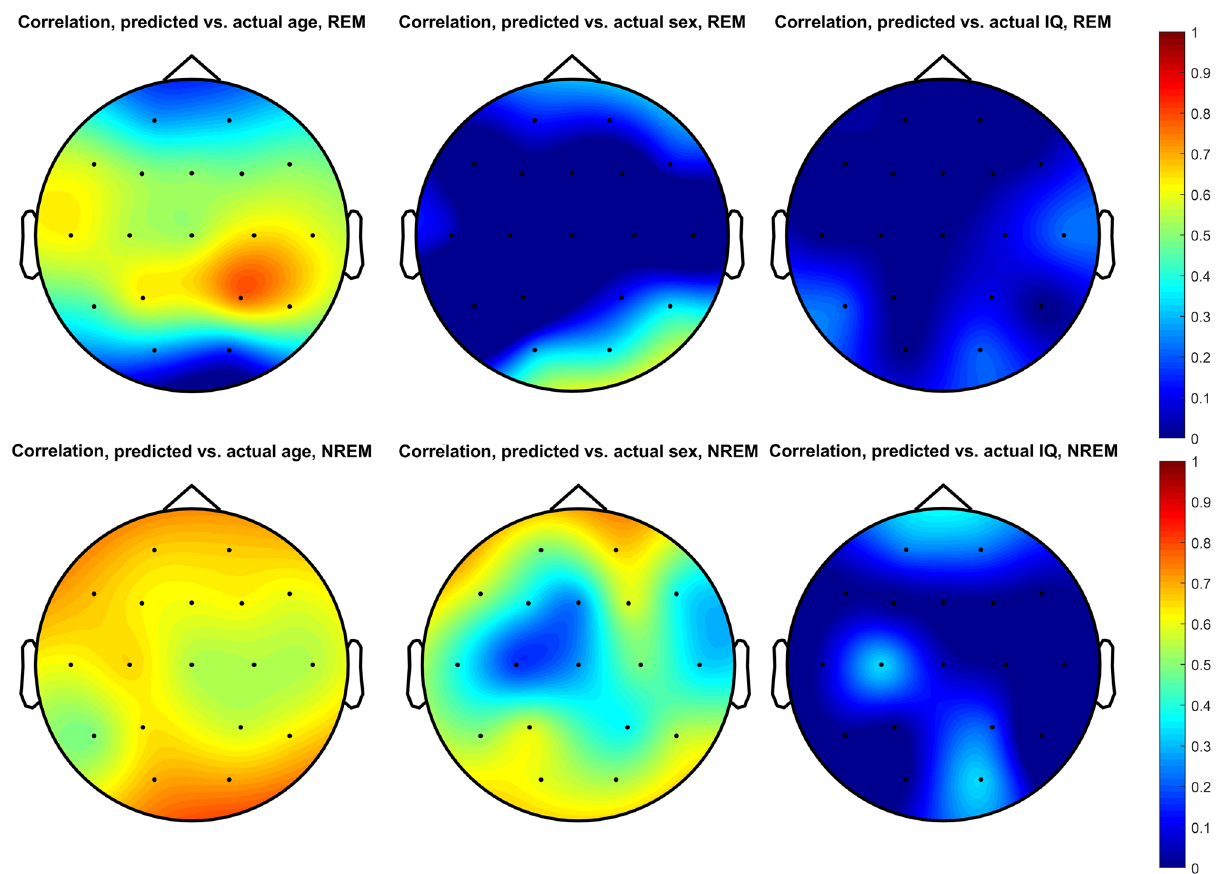
Figure 7. The performance of elastic net regression models predicting age, sex and IQ from the envelope spectrum. Topographic plots illustrate the correlation between predicted and actual phenotypes in the validation sample. (Elastic net regression models were run separately for each channel). The correlation for channels on which the elastic net model did not converge is set to 0 and not counted towards the average performance described in the text. Oscillation